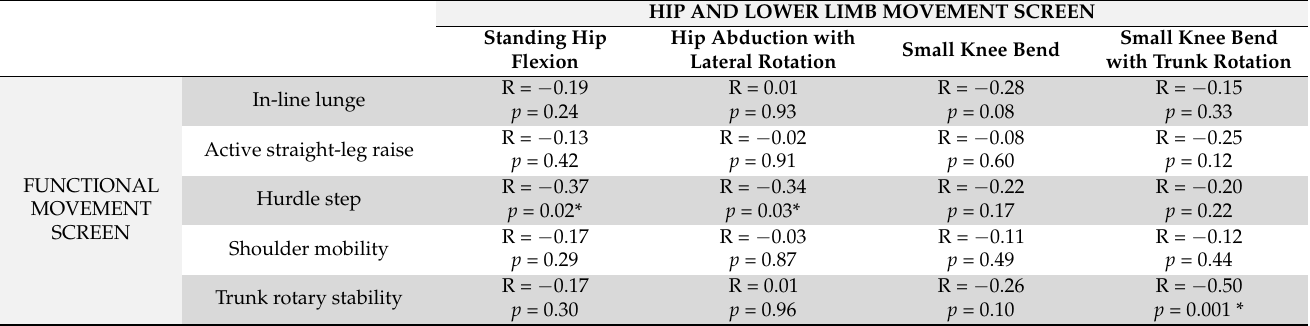
Table 2. Spearman correlation for combined score of asymmetrical